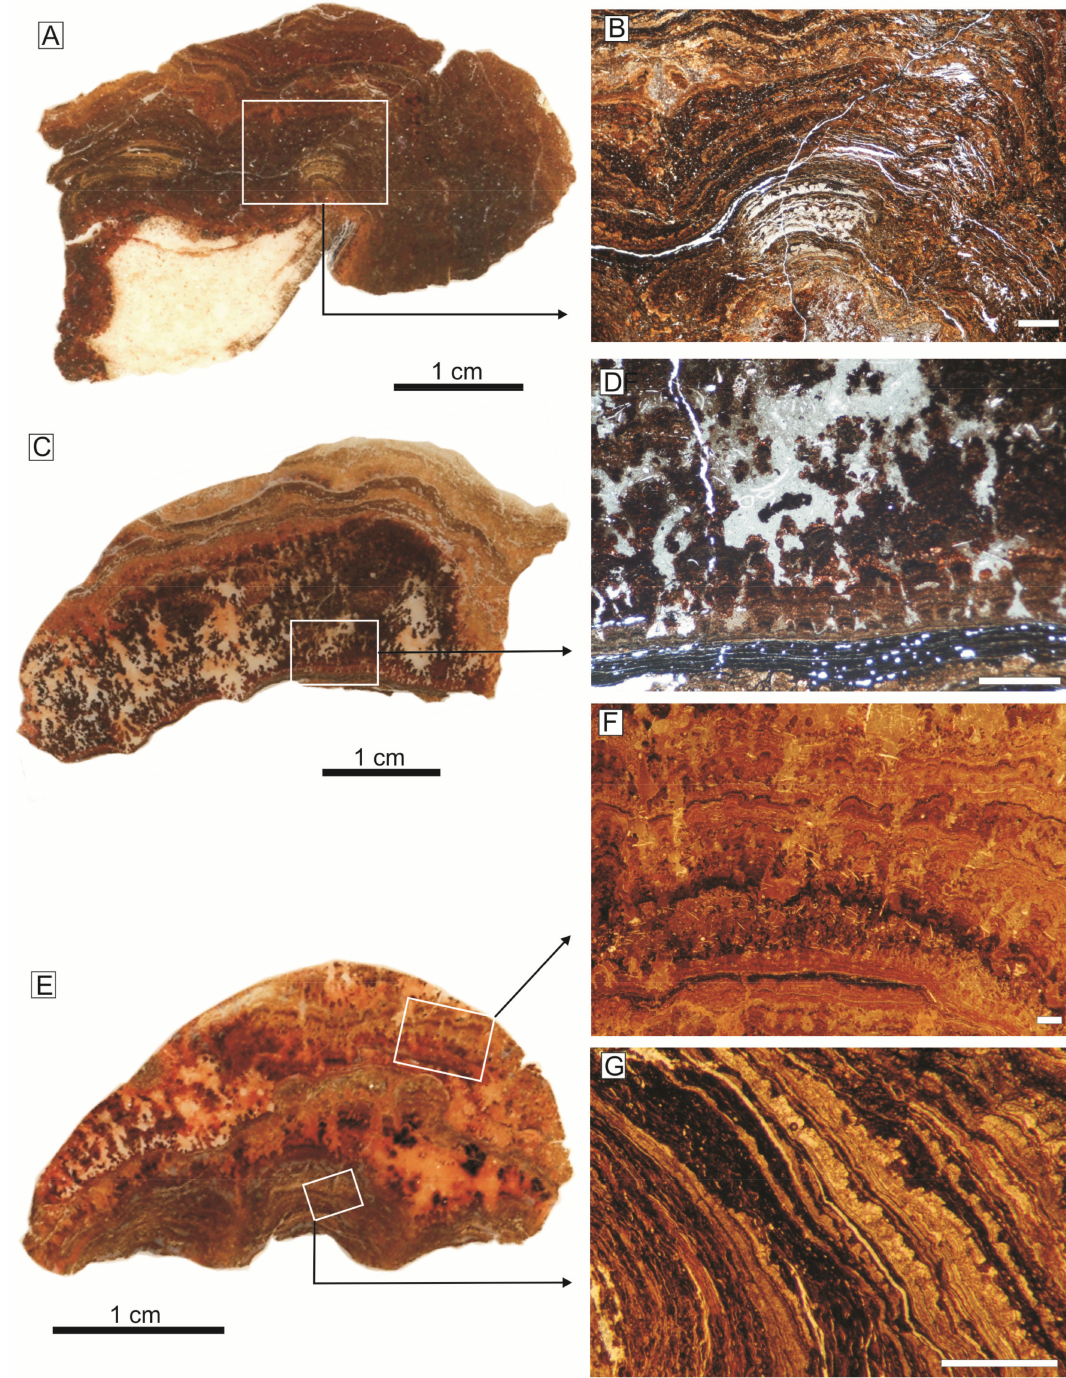
Figure 6. Polished slabs and details of laminated fabrics from the iron crusts of the Eastern External Subbetic. ( A , B ) Fragment of an iron macro-oncoid from Qu í par outcrop (Callovian-Oxfordian hardground) and detail of laminated fabric in thin section. ( C , D ) Fragment of Fe crust from L ú gar outcrop (Bathonian hardground) with planar and arborescent laminated fabrics. ( E – G ) Fragment of iron laminated crust (L ú gar outcrop, Bathonian hardground) with planar and arborescent lamina-bearing rhythms. Scale bars for microfacies 1